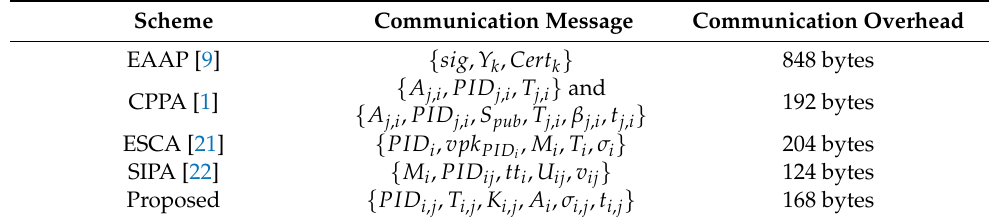
Table 2. Comparison of communication